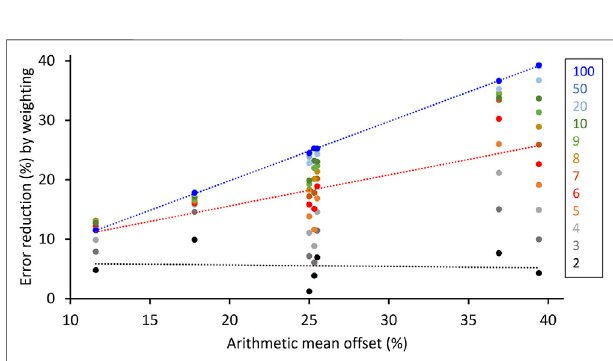
FIGURE 12 | Error reduction by computing weighted instead of arithmetic means from intra-annual proxy-SST data of Arctica islandica shells as shown in Figures 5 , 6 , 8 – 11 (i.e., excluding cases where the arithmetic mean provides superior results, i.e., Figure 7 ). With increasing sample resolution (black to blue), the weighted mean agrees better with the instrumental SST average. Numbers in box indicate sample depth, i.e., number of intra-annual samples. For further details Supplementary Table S3